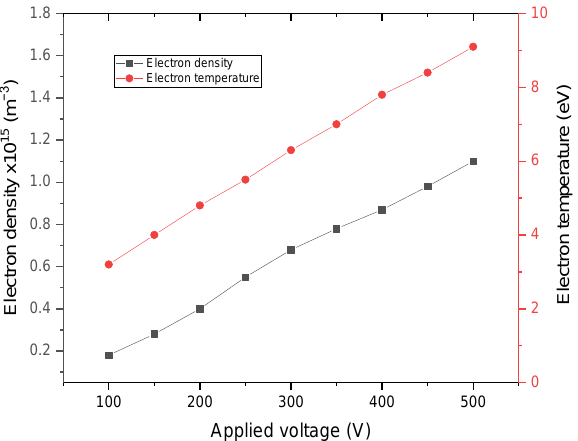
Figure 10. Density and temperature of electrons as a function of applied voltage in Ar/O 2 mixture (O 2 = 20%), f = 13.56 MHz, and working pressure 0.3 Torr.